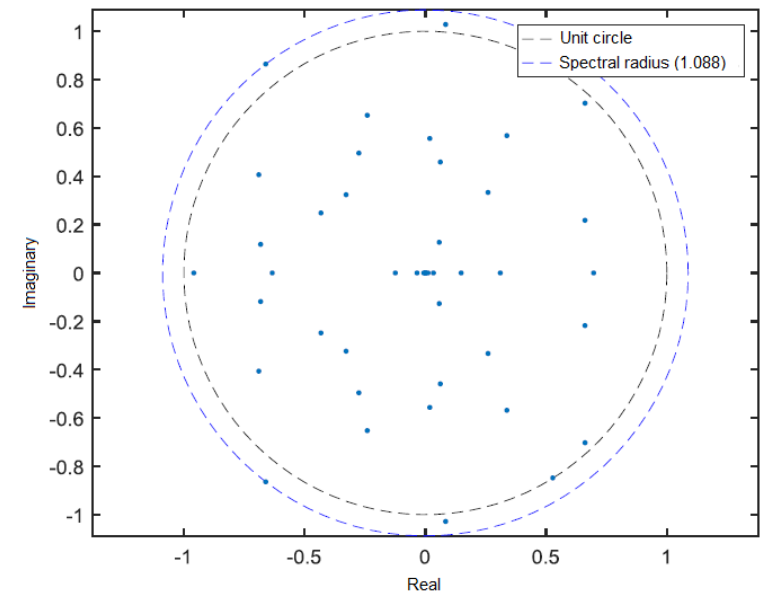
Figure 5. Eigenvalues of W . Adapted from Gouveia